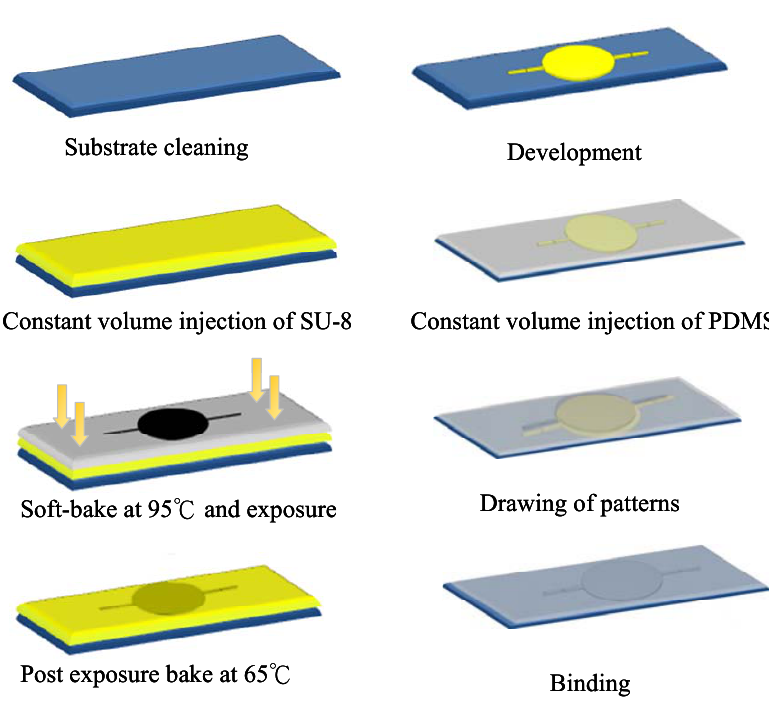
Figure 7. Diagrams for the manufacturing processes for the flow channel of the NMPV micro-pump system.